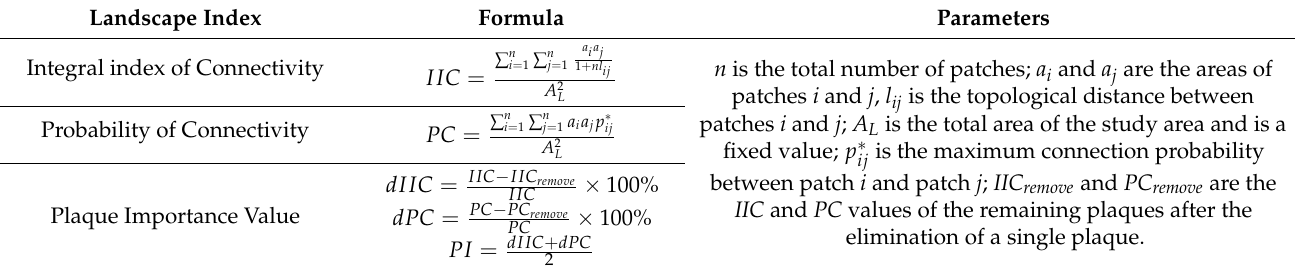
Table 2. Landscape index formula.